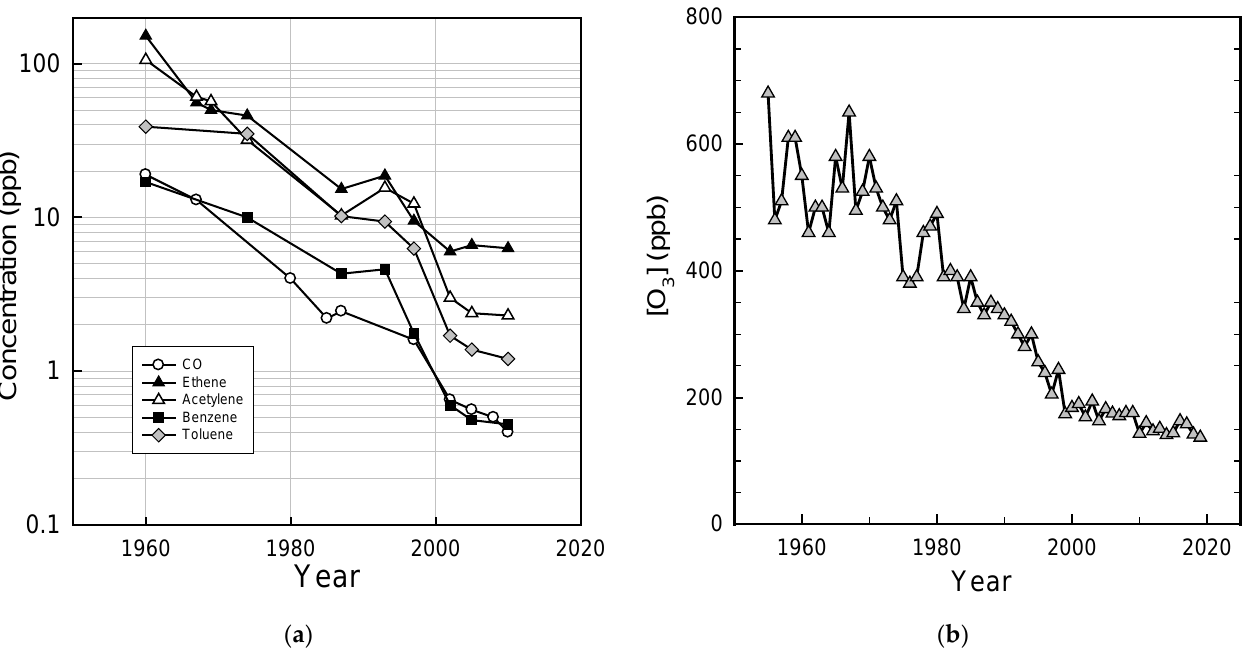
Figure 5. Progress in ambient air quality in the Los Angeles area: ( a ) CO and volatile organic compound concentrations 1960–2010 (data are from Warneke et al. [54]); ( b ) peak ozone levels (1955–1972 data are from the South Coast Air Quality Management District [55], 1973–2019 data are from the California Air Resources Board